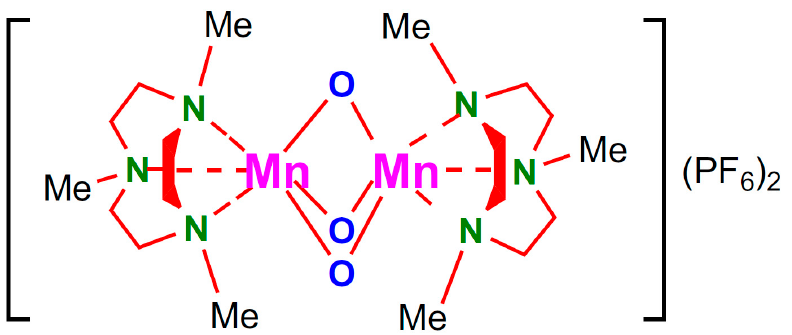
Figure 19. Binuclear manganese complex 24 which catalyzes a very efficient oxidation with peroxides, Adapted from [120], Copyright (2017) with permission of Elsevier.